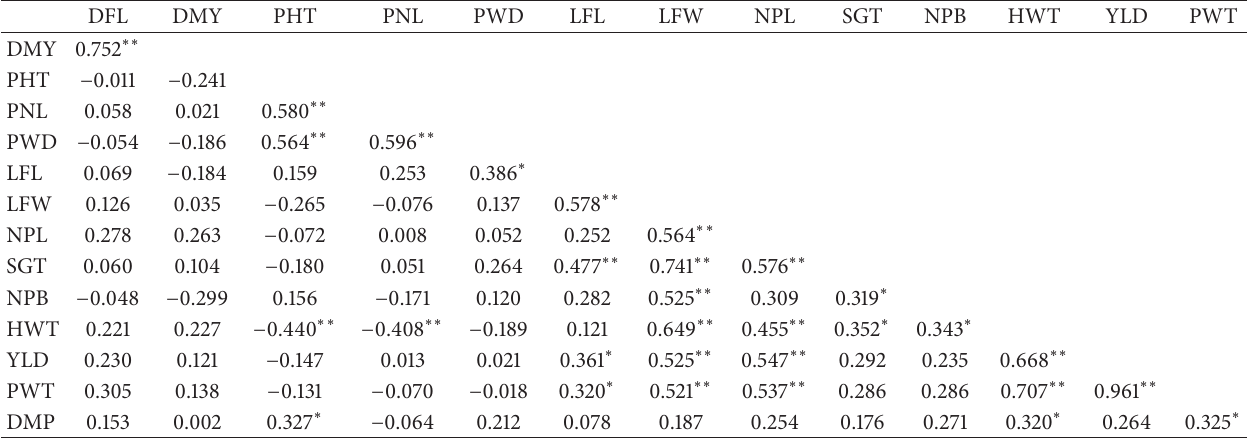
Table 3: Pearson’s correlation coefficients of quantitative traits.